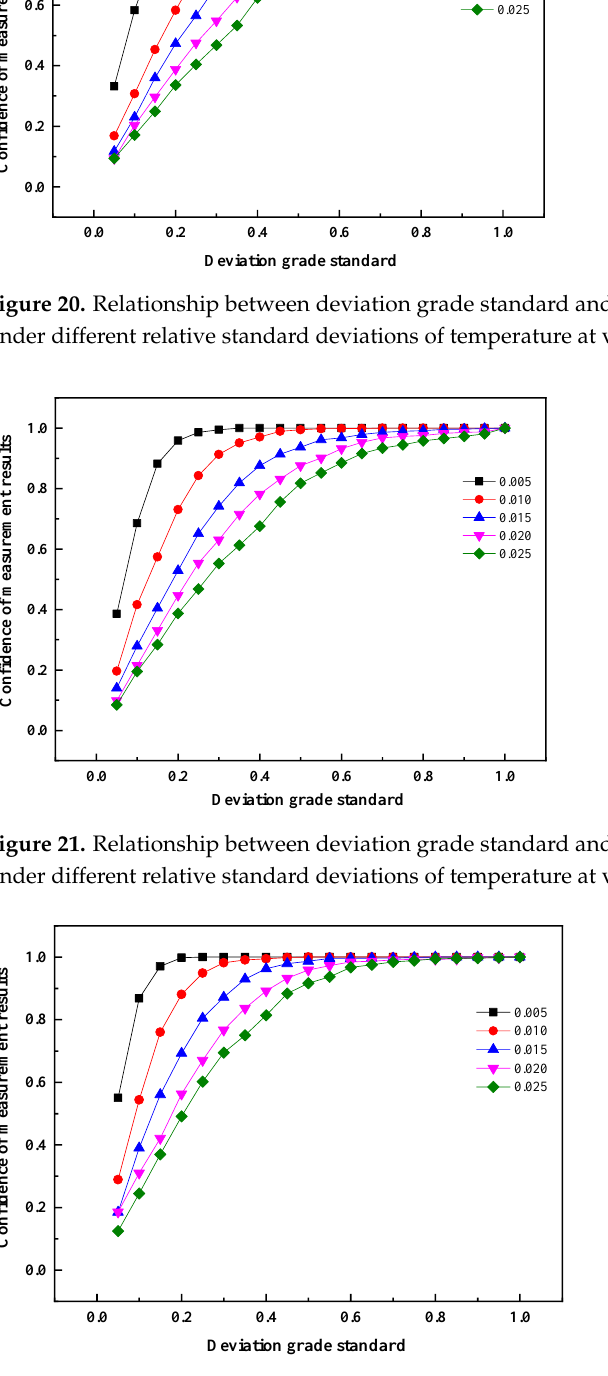
Figure 22. Relationship between deviation grade standard and confidence of measurement results under different relative standard deviations of temperature at velocity 4.3 m/s.